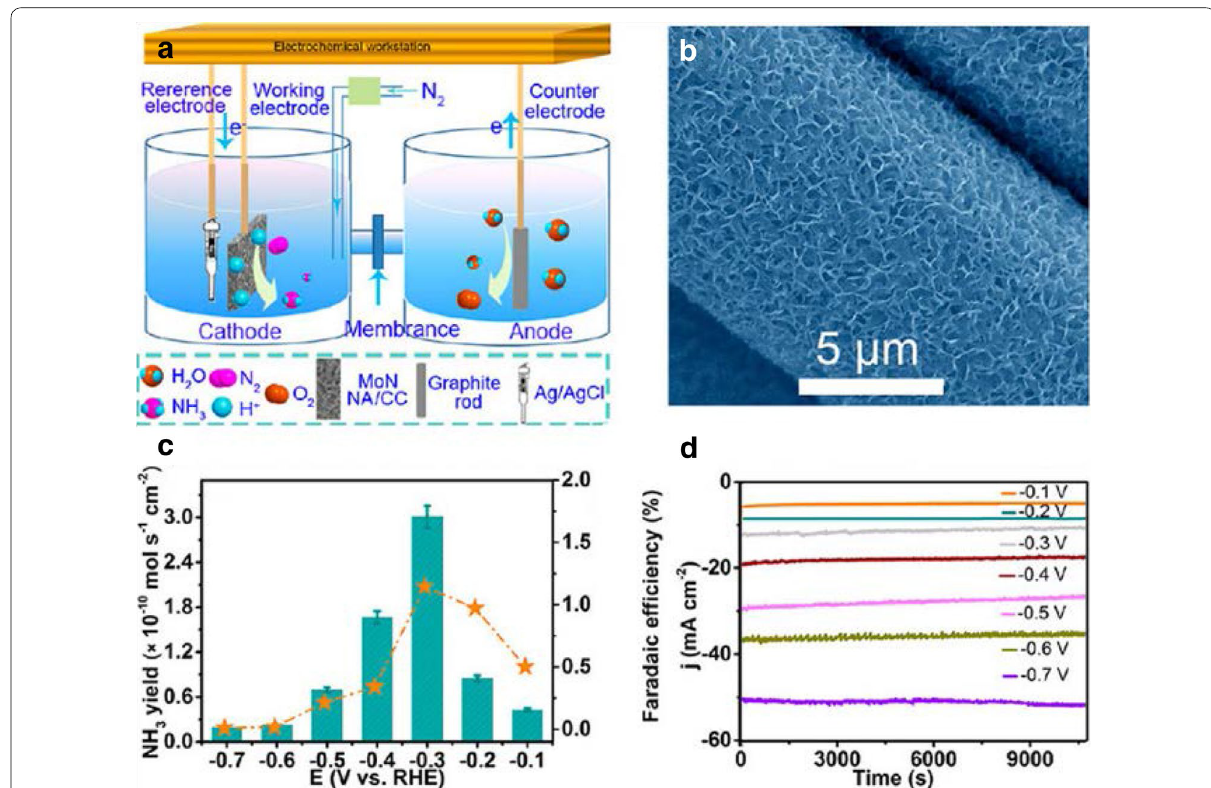
Fig. 6 a Schematic illustration for electrocatalytic NRR. b SEM image showing MoN NA/CC. c NH 3 yields and FE at different potentials. d Chronoamperometry results at various potentials (Reproduced with permission [34] Copyright 2018, American Chemical Society )